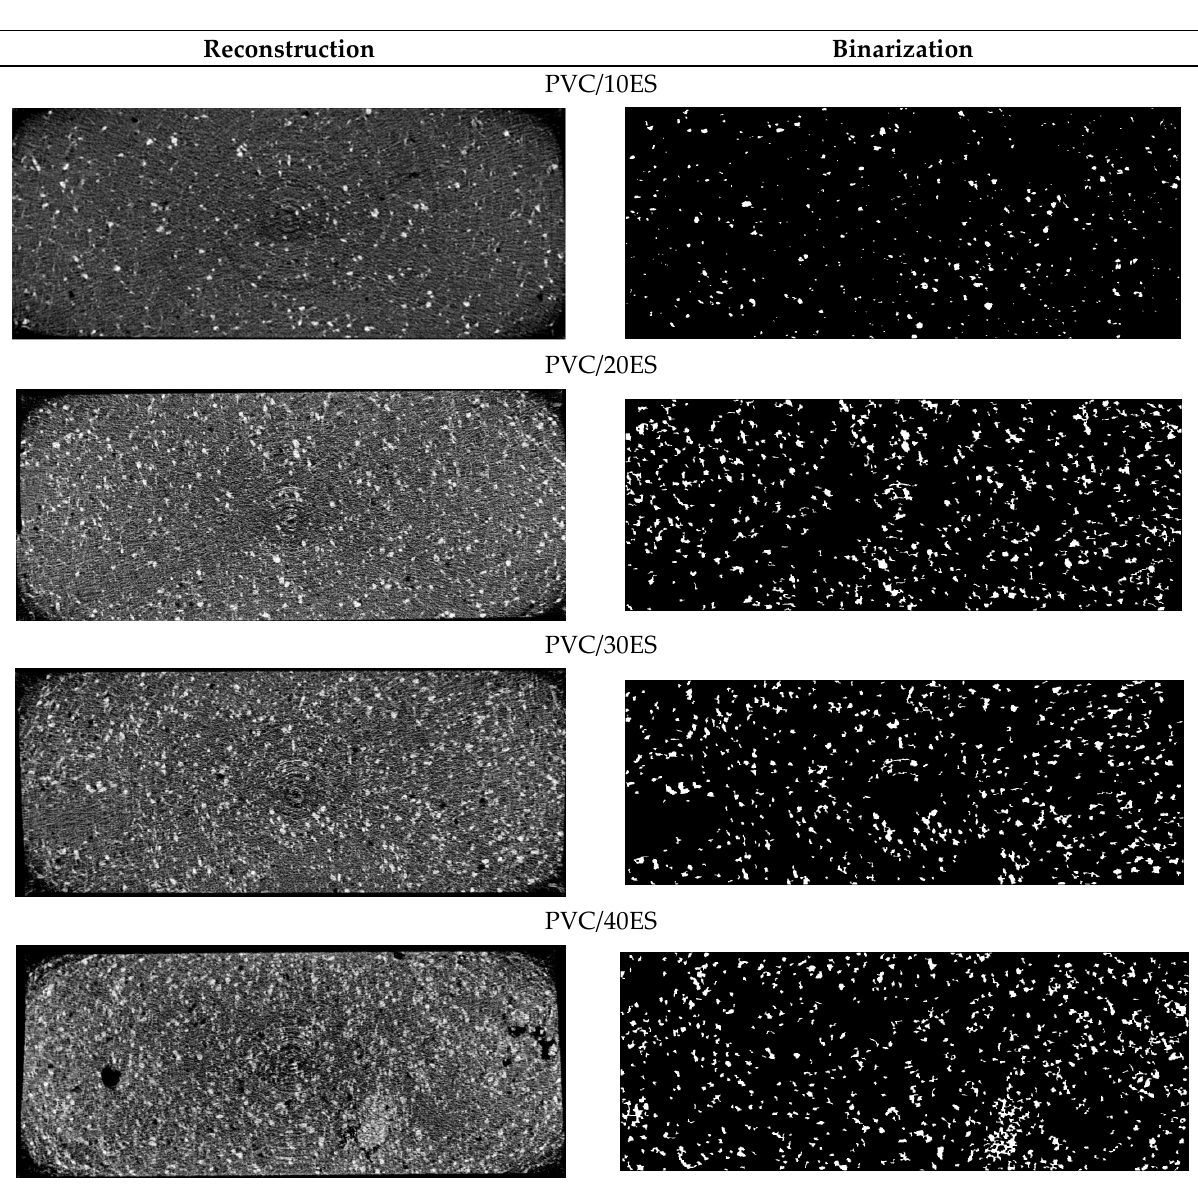
Figure 11. Single layers/cross-sections after reconstruction ( left column ) and the same layers after binarization ( right column ), with white spots as ES particles.